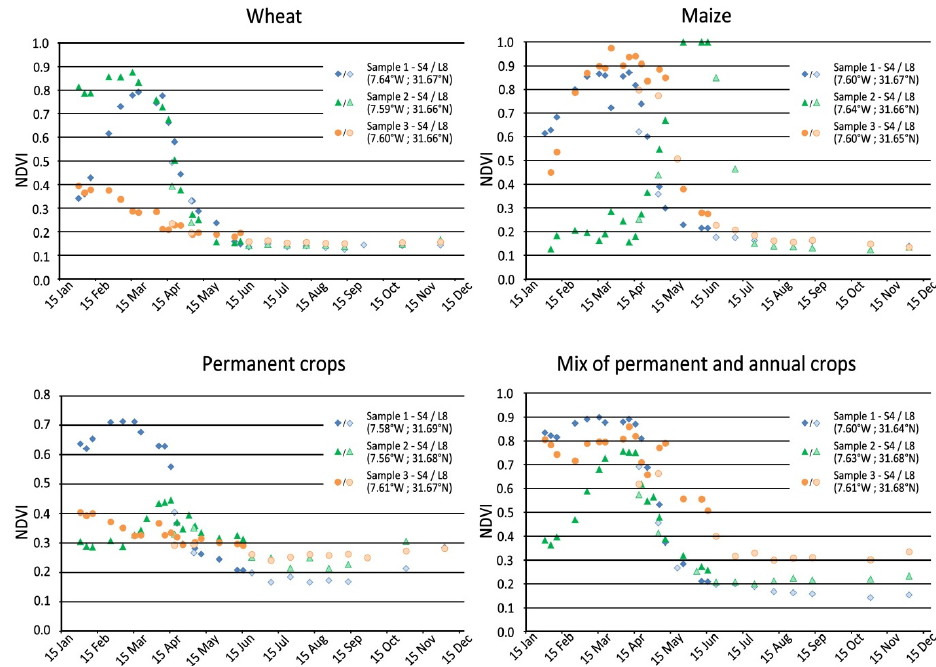
Figure 7. NDVI temporal profiles from parcels of wheat, maize, permanent crops and mix of permanent and annual crops over the Moroccan site. For each crop, temporal profiles of three parcels are provided, plain and hatched dots showing NDVI values obtained from SPOT4 (Take 5) and Landsat 8 images respectively .